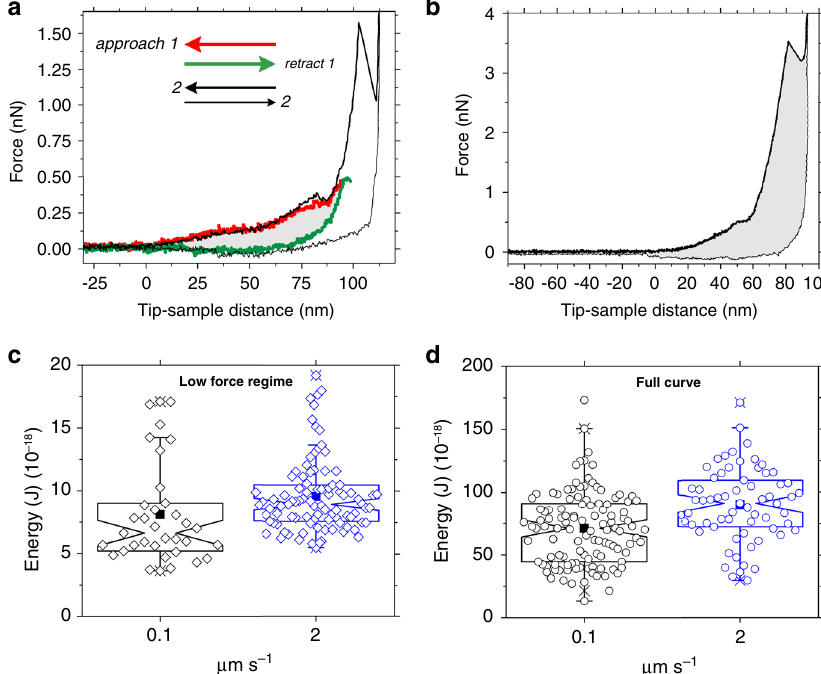
Fig. 3 Lamin fi laments absorb energy under continuous applied force. a To estimate the energy absorbed during the initial stretching of a lamin fi lament (low-force regime), a repetitive force protocol was used. A force of 0.5 nN was applied (approach, red curve) and released (retract, green curve); the area between the red and green curves (gray) gives the energy absorbed by the lamin structure. The same fi lament was subjected to a higher force until failure was detected (bold black curve). The plateau in the low-force regime was reversible (compare black and red curves) in majority (89%) of the FE curves ( n = 133). The reversibility shows that the cantilever tip could be stably and reproducibly placed on a lamin fi lament and that a single fi lament was interrogated. b The area (shaded gray) between the approach curve (bold black) and the retract curve (thin black) denotes the energy dissipated during the entire process of failure. c , d The energy absorbed in the low-force regime was ≈ 10 − 17 J ( n = 40 at 0.1 μ m s − 1 , n = 93 at 2 μ m s − 1 , n is the number of single experimental events as shown in a , b ), an order of magnitude lower than that absorbed during the irreversible failure ≈ 10 − 16 J ( n = 115 at 0.1 μ m s − 1 , n = 65 at 2 μ m s − 1 ). Each notch-box includes 25 – 75% of the data, and each diamond and circle denotes a single event from a fi lament. The solid squares denote the mean and the whiskers signify 1 – 99% of the